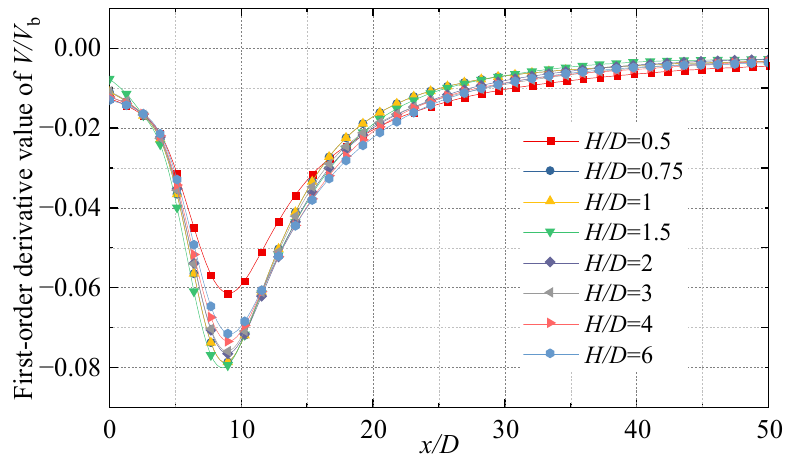
Figure 12. First-order derivative curve of V / V b . different horizontal heights ( Re = 35,100). At H / D = 0.5, z / D = ±0.25 and y / D = 0.25, the values of V / V b almost remain as a constant in the range of 0 ≤ x / D ≤ 2. The values of V / V b for each operating condition decrease gradually with the increase in the jet flow distance. The values of V / V b in the range of 2 ≤ x / D ≤ 40 is located at z / D = − 0.25, y / D = 0.25, and z / D = 0.25 cross-sections from the largest to the smallest. This indicates that the velocity of the jet fluid on the side close to the wall is increased due to the influence of the wall. The values of V / V b at z / D = 0.5 and y / D = 0.5 rapidly increase from 0 to 0.6 in the region of 0 ≤ x / D ≤ 2. Meanwhile, the values of V / V b at z / D = 0.5 and y / D = 0.5 gradually decrease. For H / D ≥ 2, the values of V / V b at z / D = ±0.25 and y / D = 0.25 are almost equal, and the trend of velocity distribution is the same. Combined with Figure 8, the overall dimensionless velocity V / V b of the jet is less and less influenced by the wall as H / D increases. In summary, the influence of the bottom wall on the jet is mainly manifested by limiting the diffusion in the − z direction, increasing the velocity in the near-wall area, and the influence of the bottom wall on the jet decreases with the increase in the horizontal height until it disap- pears.